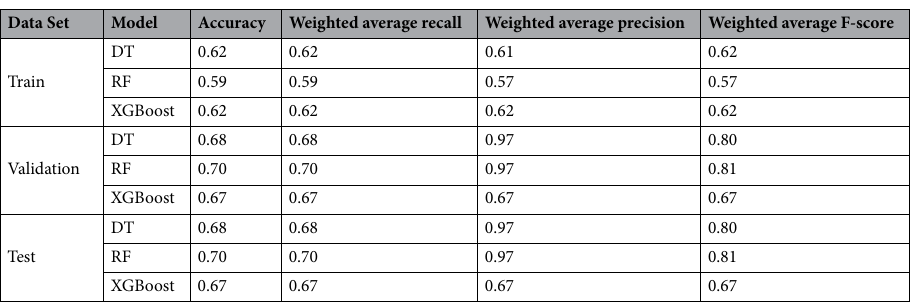
Figure 6. Result of DT with a maximum depth of 4.